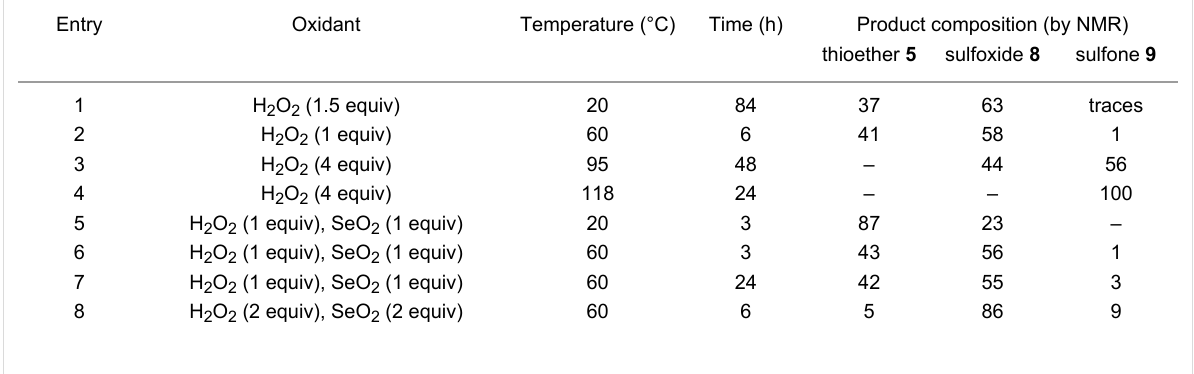
Table 1: Conditions and product mixture composition for oxidation reaction of thioether 5